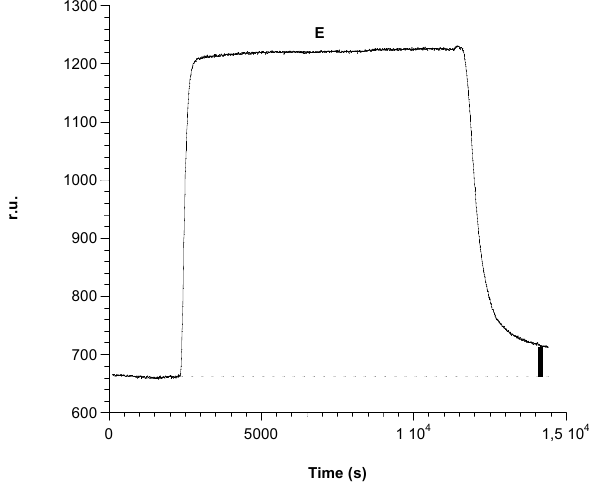
Figure 8. Example of ampicillin detection 1 × 10 − 1 M with sandwich format. Δ r.u (bold line) is related to the concentration ( E ) 1 × 10 − 1 M, before and after the association of ampicillin.